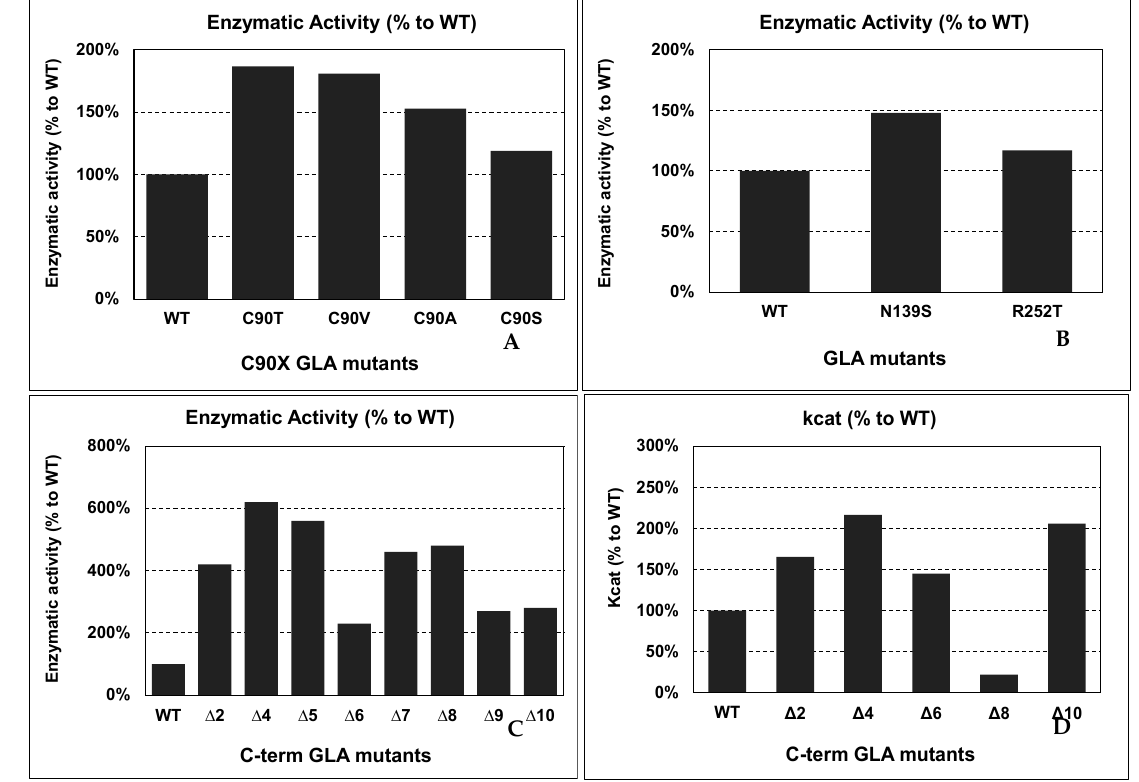
Figure 3. Enzymatic activity of several “improved” GLA mutants, compared to wild-type GLA enzyme. The mutants shown are examples described by several authors. Abbreviations: WT: wild-type GLA; Δ X: C-terminal deletions corresponding to “X” missing residues.